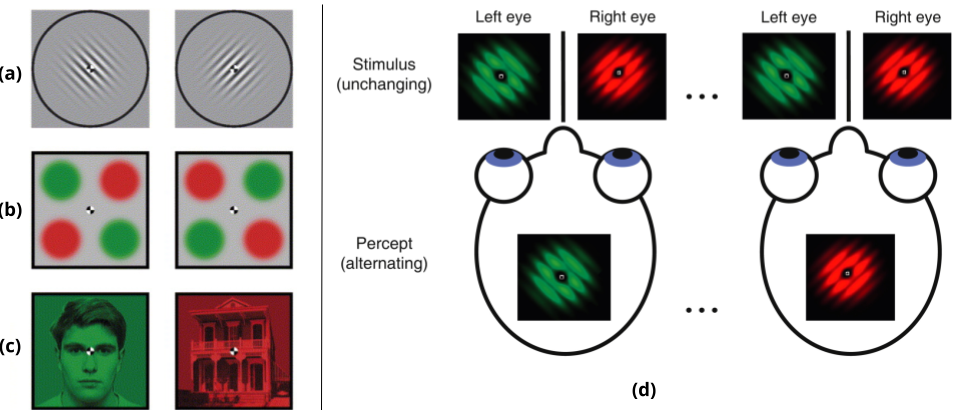
Figure 2. Binocular Rivalry (BR): When two different images are presented to the two eyes, the per- ceptual experience switches spontaneously between the images. On the left, three examples taken from [8]: ( a ) dichoptic orthogonal gratings (similar to Gabor patches); ( b ) stimuli used to study interocular grouping; ( c ) BR stimuli with complex objects, a face and a house. On the right, ( d ) a schematic illustration of BR phenomenon taken from